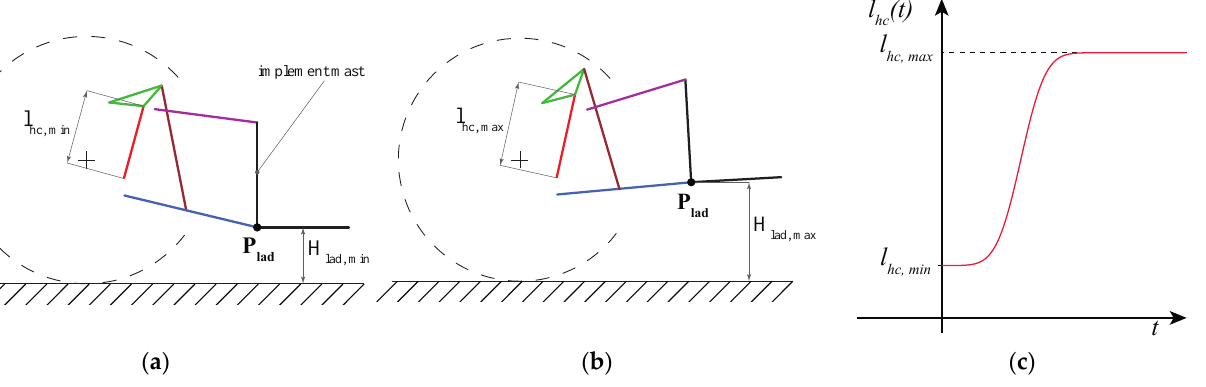
Figure 3. Reference manoeuvre: ( a ) TPH at lower height; ( b ) TPH at higher height; ( c ) hydraulic lift cylinders extension law.